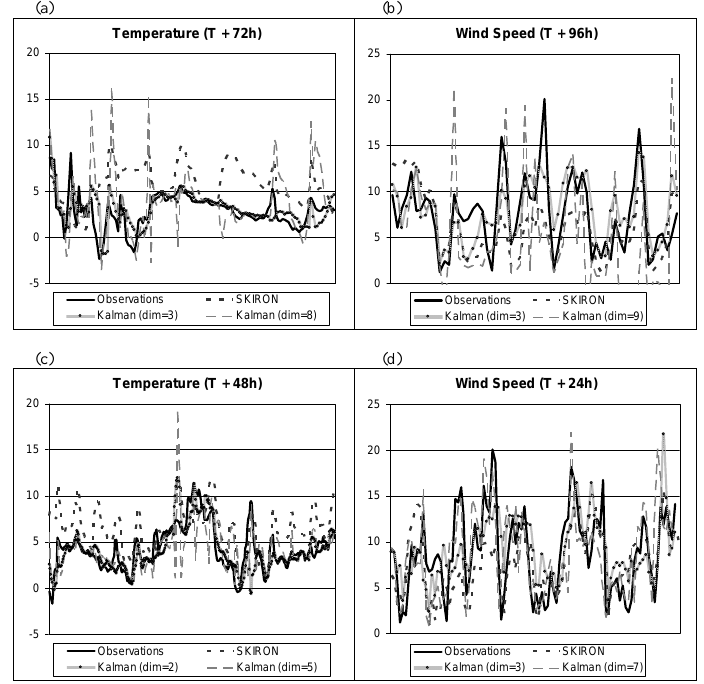
Fig. 2. Time series of the (a, c) air temperature and (b, d) wind speed observed, forecasted and Kalman filtered for different forecasting hours with four different polynomials.